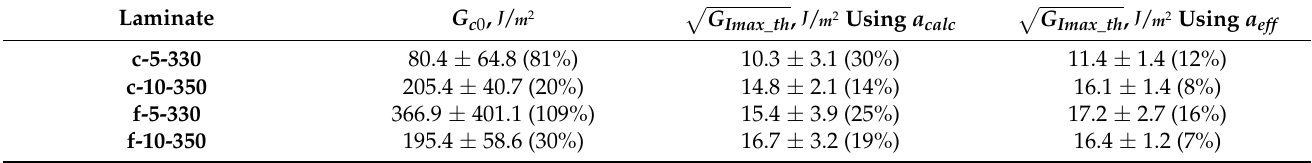
Table 5. Quasi-static initiation value of the crack growth G c 0 and Laminate G c 0 , J / m 2